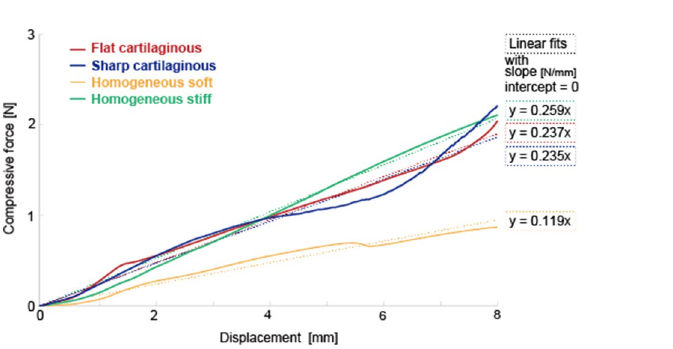
Figure 5. Robot fabrication process based on molding. The mold is made of multiple acrylic parts: ( a ) Ecoflex 00-20 is casted on a mold and cured in an oven; ( b ) servomotors are placed inside the mold; ( c ) cartilages made of Sylgard 184 are placed above the servomotors (cartilages are fabricated separately in another mold); ( d ) mold is filled with Ecoflex 00-20.